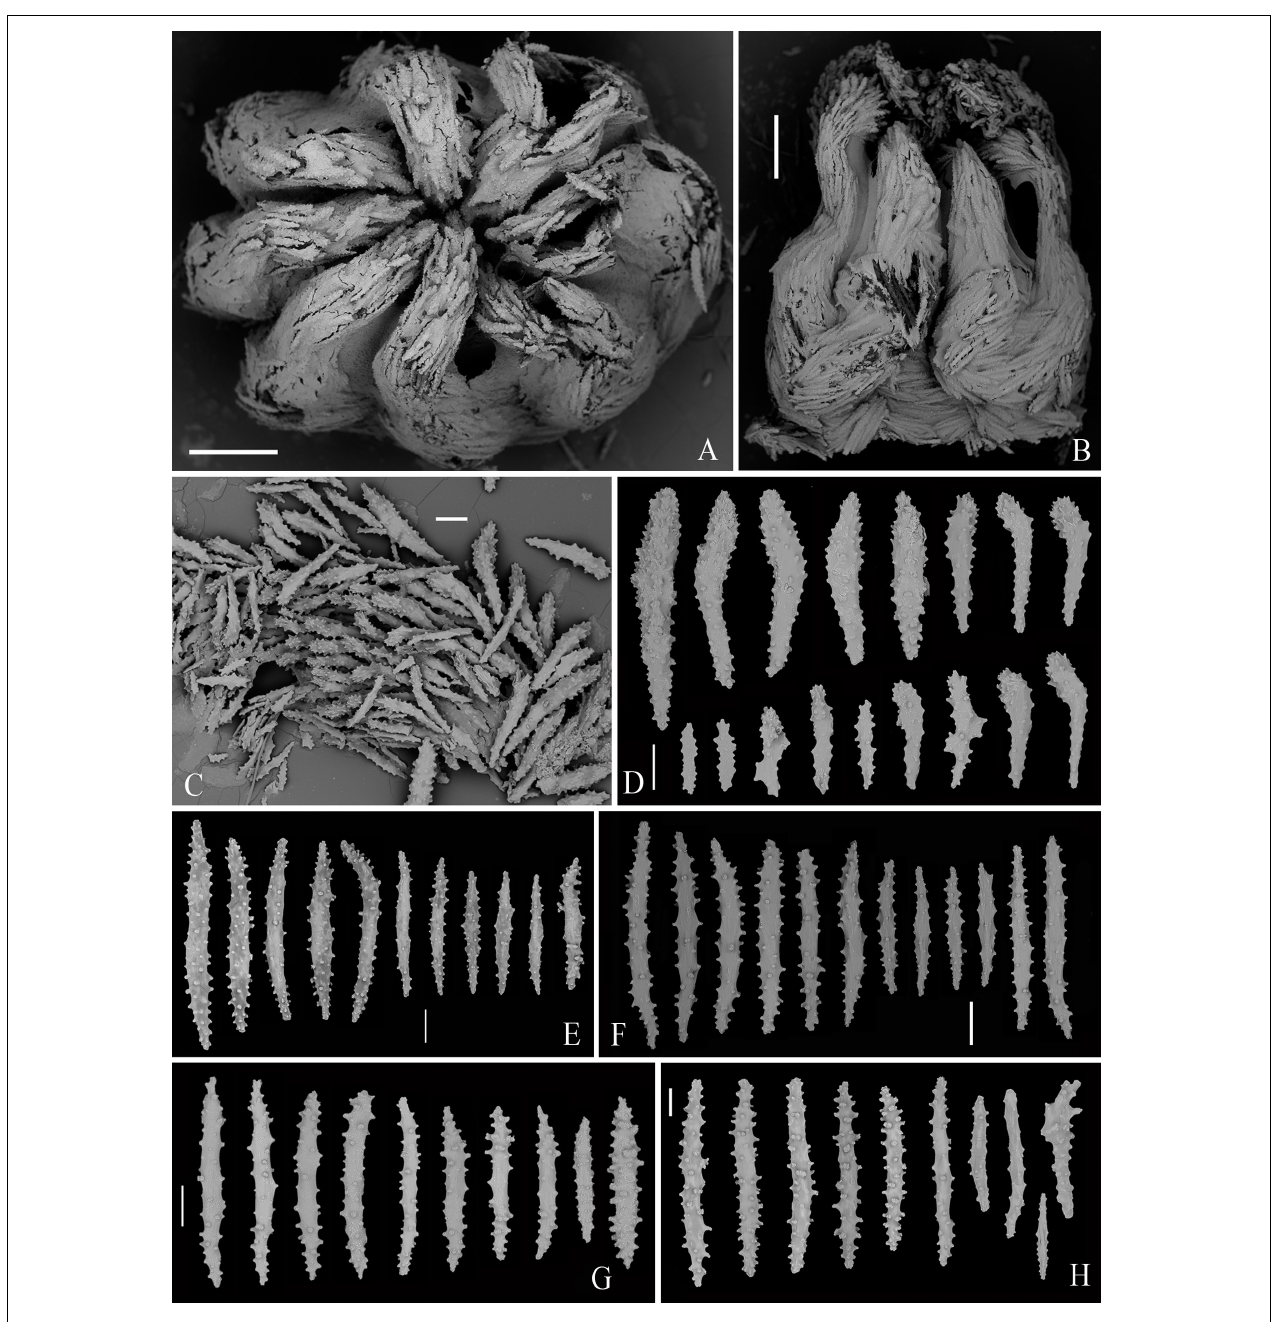
FIGURE 12 | SEM of polyps and sclerites from the specimen MBM286392 of Victorgorgia eminens Moore et al., 2017. (A) Upper view of a polyp head. (B) Lateral view of a polyp head. (C) Tentacular sclerites in situ . (D) Sclerites from tentacles. (E) Sclerites from point and collaret. (F) Sclerites from calyces. (G) Sclerites from cortex. (H) Sclerites from medulla. Scale bars = 0.5 mm (A,B) , and 100 µ m (C–H) .